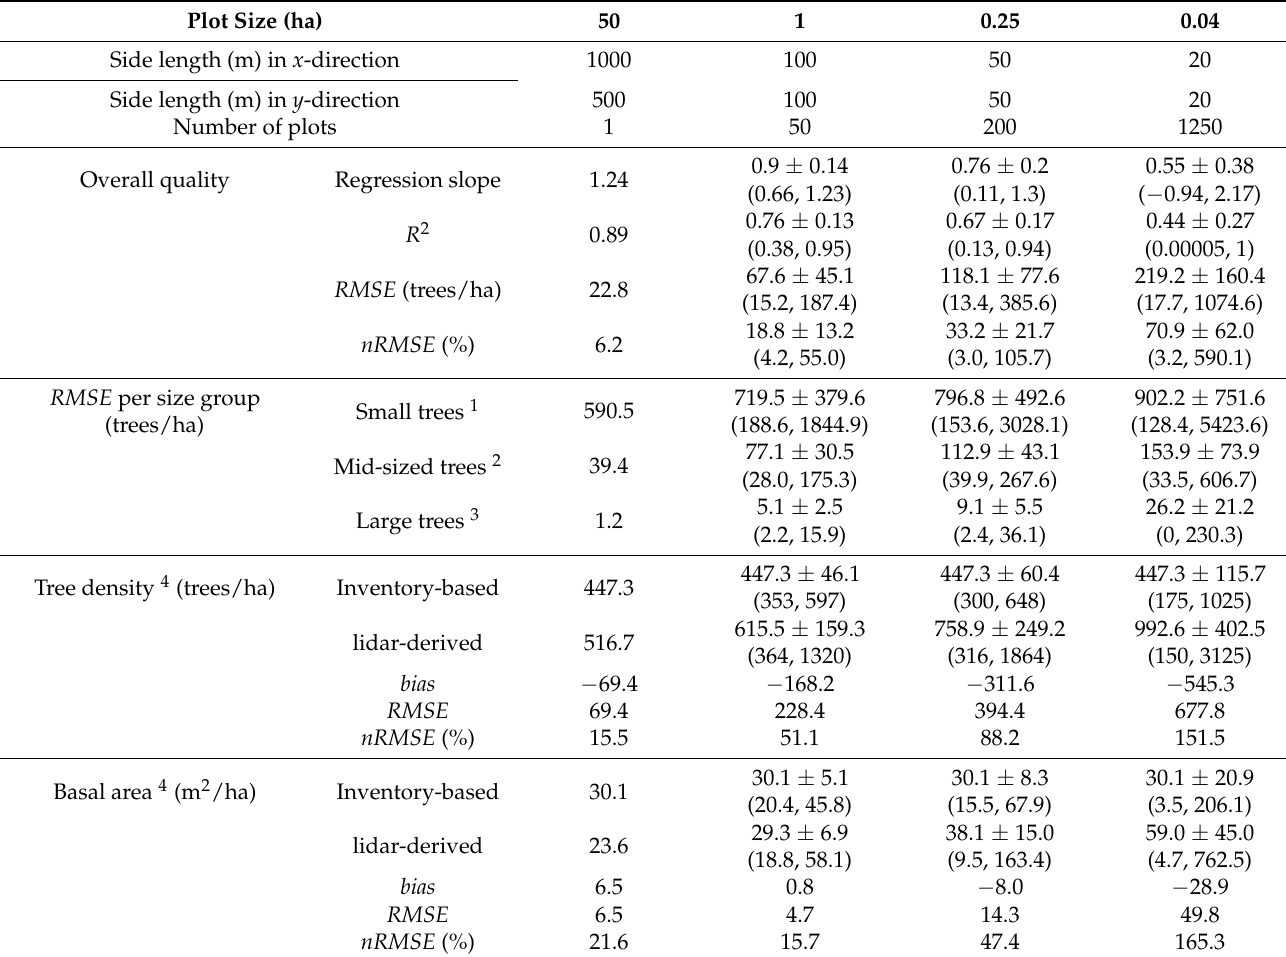
Table 3. Comparison of forest attributes derived from lidar and from the forest inventory for different plot sizes. Results are shown for the regression analysis (slope and R 2 ), RMSE and nRMSE (overall and for three different categories of small, mid-sized and large trees grouped according to stem diameter d ) and aggregated forest attributes (tree density and basal area, for stem diameter d ≥ 10 cm). For each plot size, the mean ± standard deviation (and in brackets, minimum and maximum) of the respective attribute is given. The plot size is given in ha with the number of plots and plot dimension in m × m. Forest attributes are compared between lidar and inventory also in terms of the bias , RMSE , and nRMSE (%) (see methods for details). See Table A2 for additionally analyzed plot